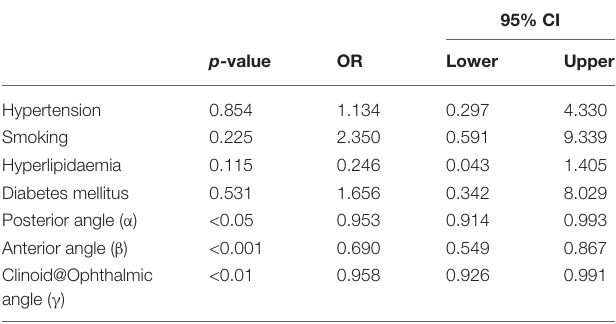
TABLE 5 | Independent factors associated with paraclinoid aneurysms